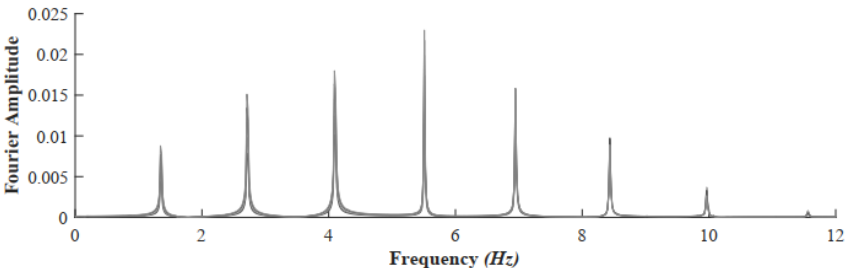
Figure 9. Measured frequency spectra of the single cable at five sensor locations on Cable 1.